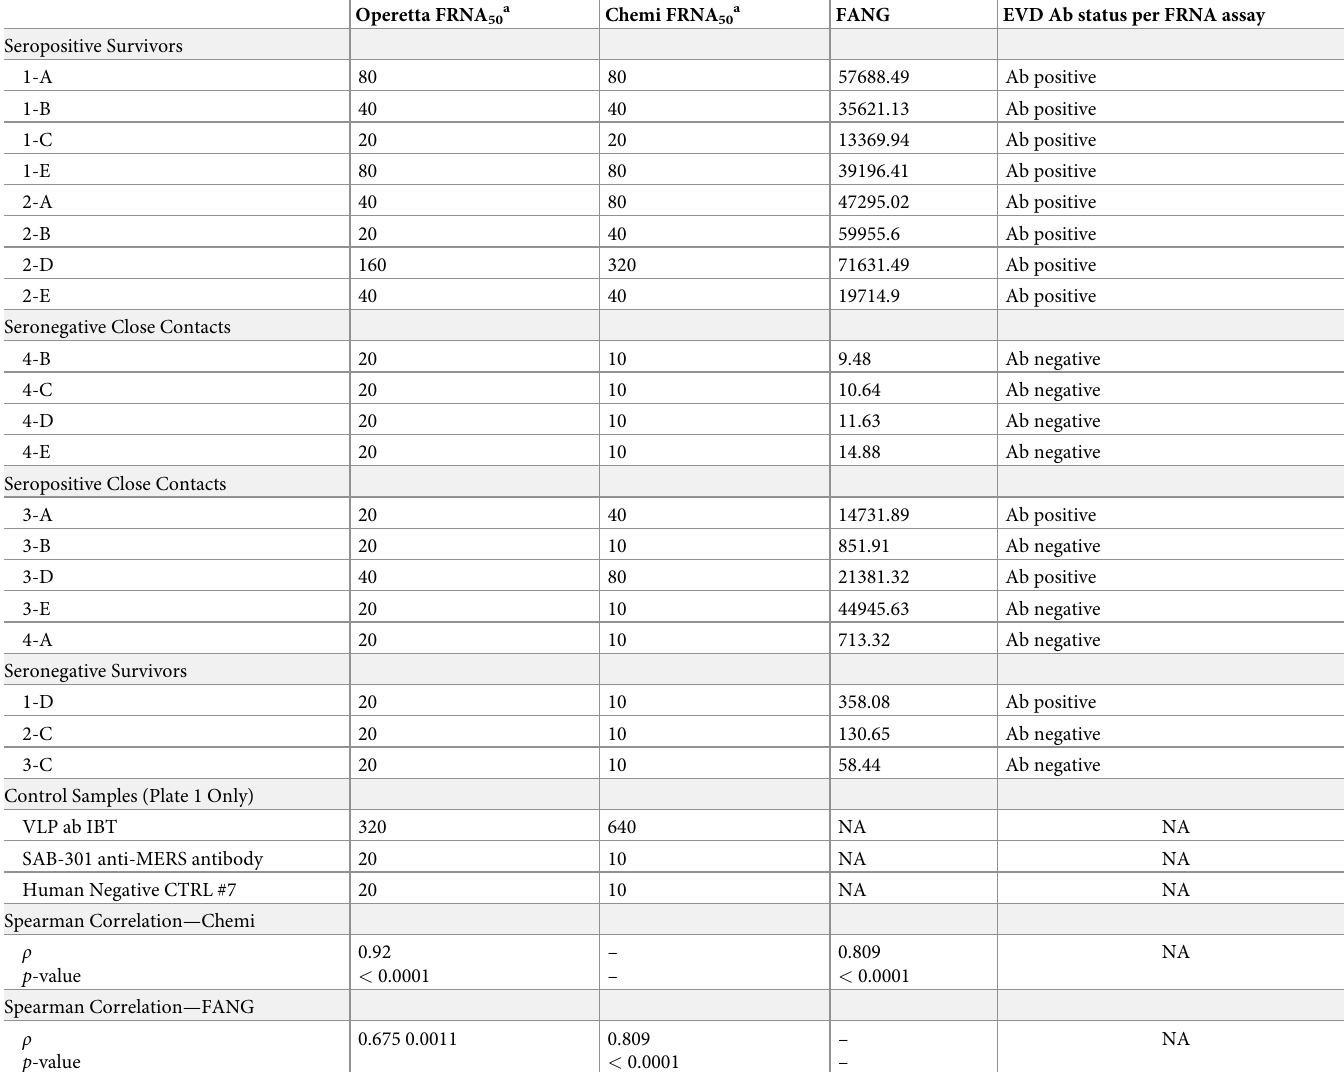
a The Operetta FRNA 50 titers and EVD Ab status results were calculated using four non-boundary fields. Operetta titers of 20 and Chemi titers of 10 indicate an estimate below 40 and 20, the LODs of the Operetta and Chemi methods,